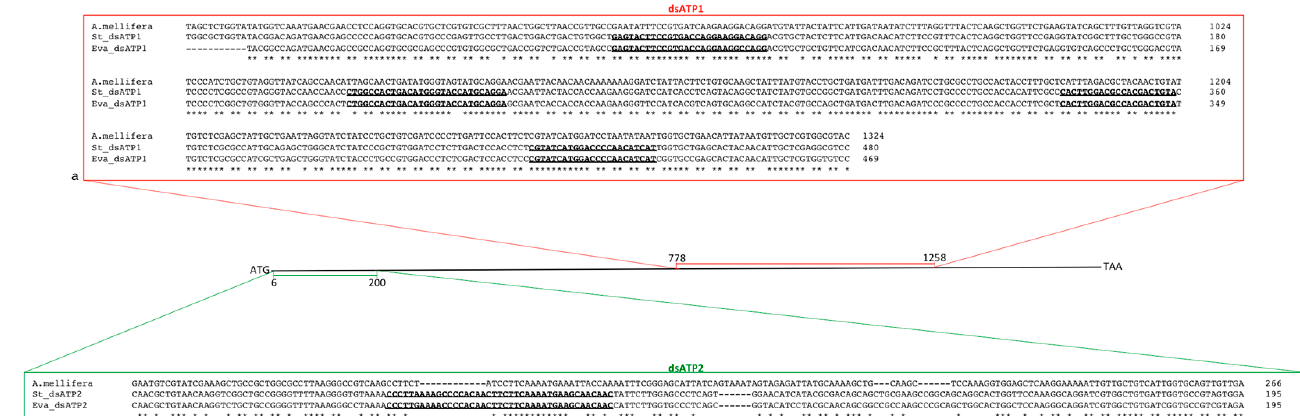
Figure 5. Localization of dsATP1 and dsATP2 on ATP synthase β coding sequence of Scaphoideus titanus . Alignments of dsATP1 ( a ) and dsATP2 ( b ) targeting ATP synthase β of S. titanus (St_dsATP1 and St_dsATP2) and Euscelidius variegatus (Eva_dsATP1 and Eva_dsATP2). ATP synthase β sequence of Apis mellifera (XM_006564829.3, LOC551766) was used as the outgroup. Stretch of 21 or more identical nucleotides between S. titanus and E. variegatus are in bold and underlined.